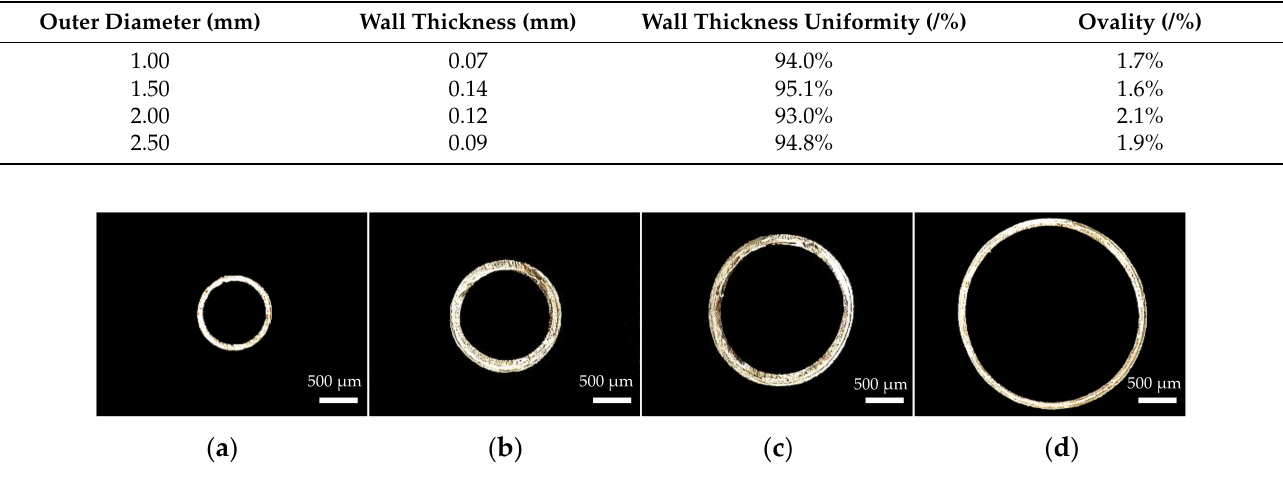
Figure 18. Cross sections of different specifications of micro tubes: ( a ) D = 1.00 mm; ( b ) D = 1.50 mm; ( c ) D = 2.00 mm; ( d ) D = 2.50 mm.